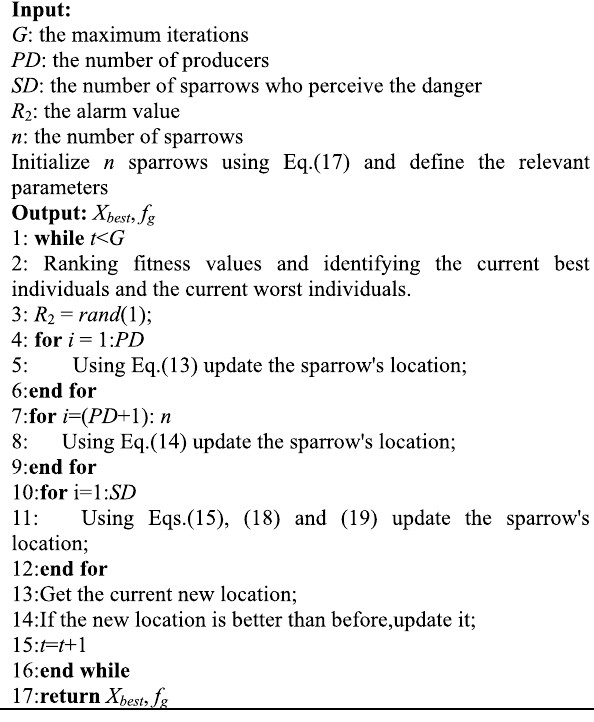
Algorithm 1. The framework of the improved SSA